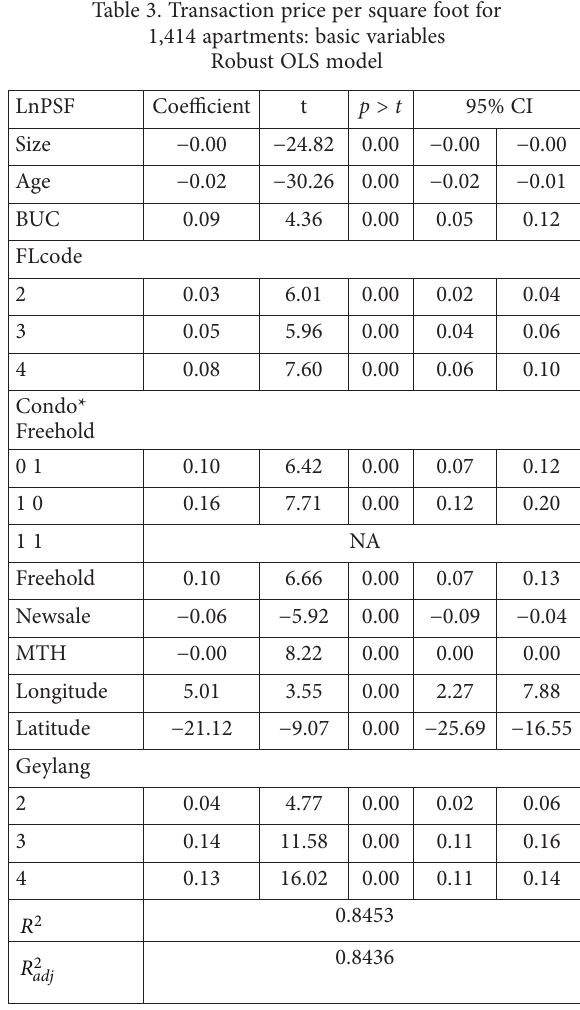
Table 3. Transaction price per square foot